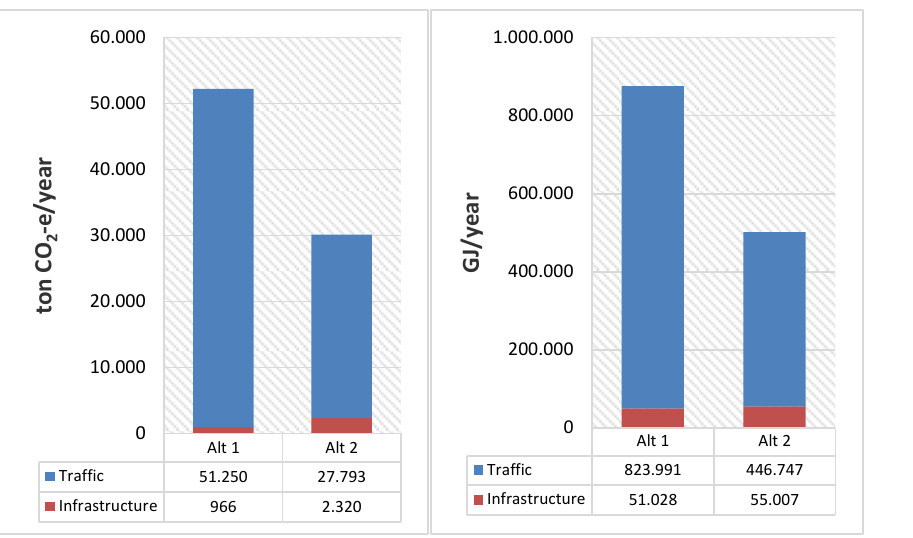
Figure 4. Annual greenhouse gas (GHG) emissions and cumulative energy demand (CED) from road infrastructure and traffic for Alt.1 and